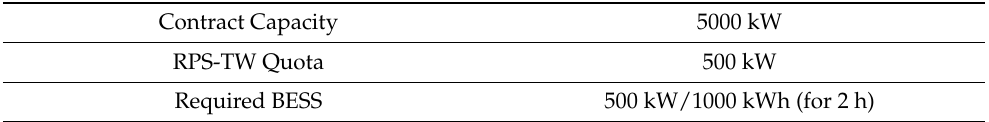
Table 7. Sample calculation: BESS option.